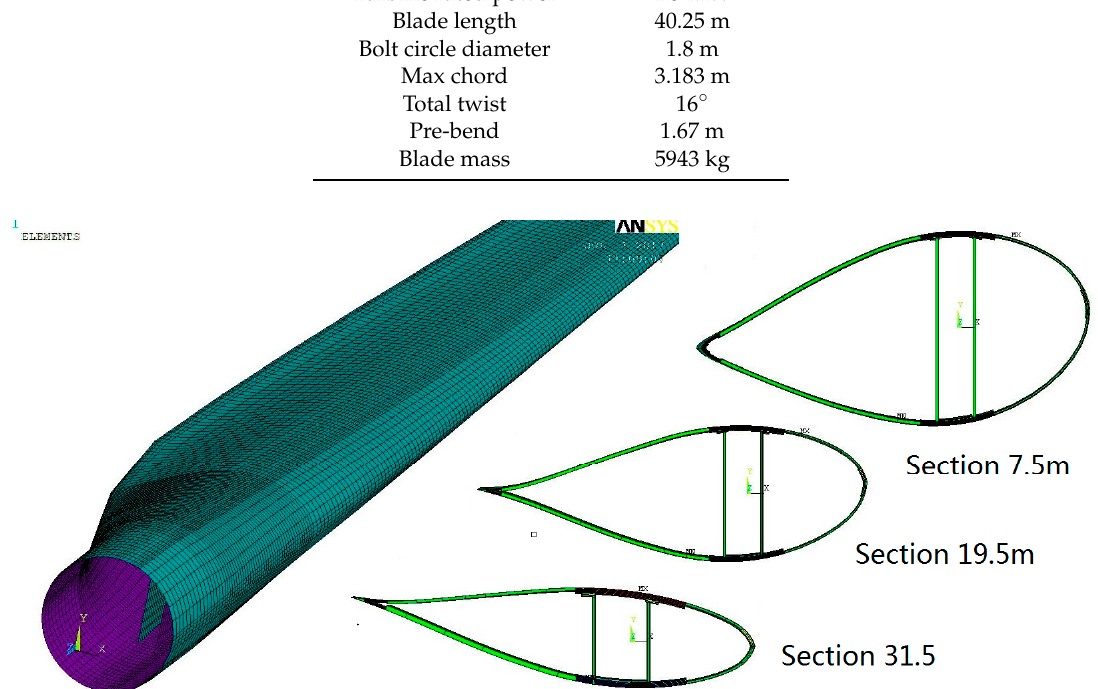
Energies 2017 , 10 , 1058 Figure 5. Finite Element Method (FEM) mesh of the test blade with different cross-sections.